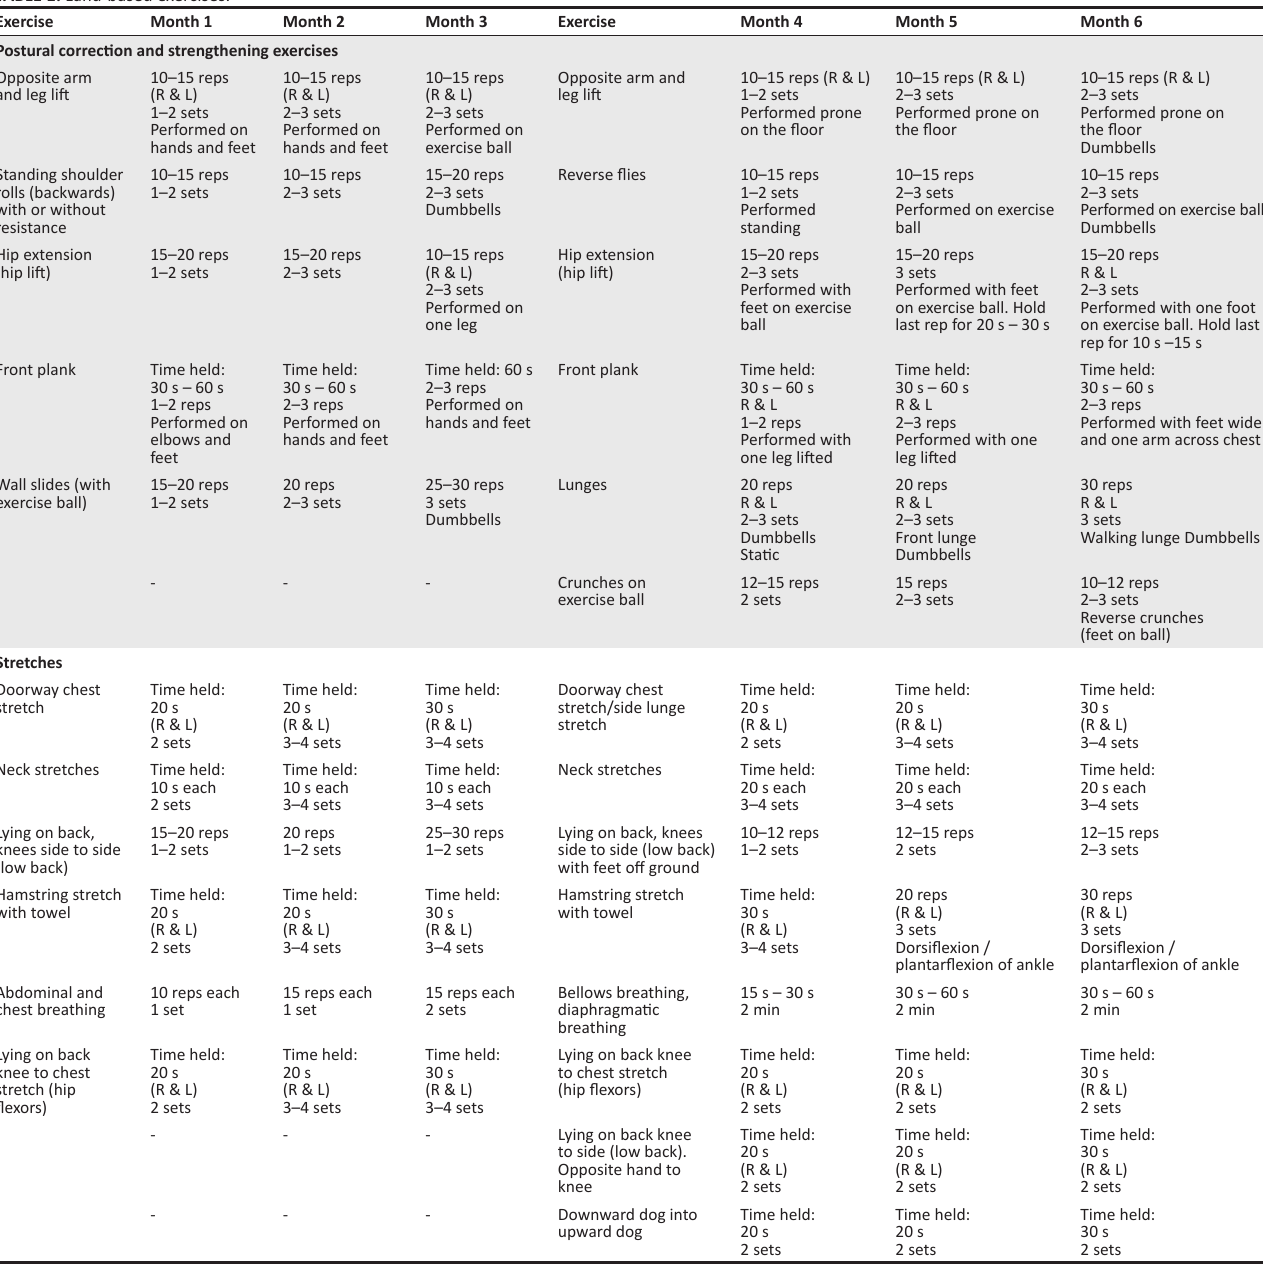
TABLE 1: Land-based